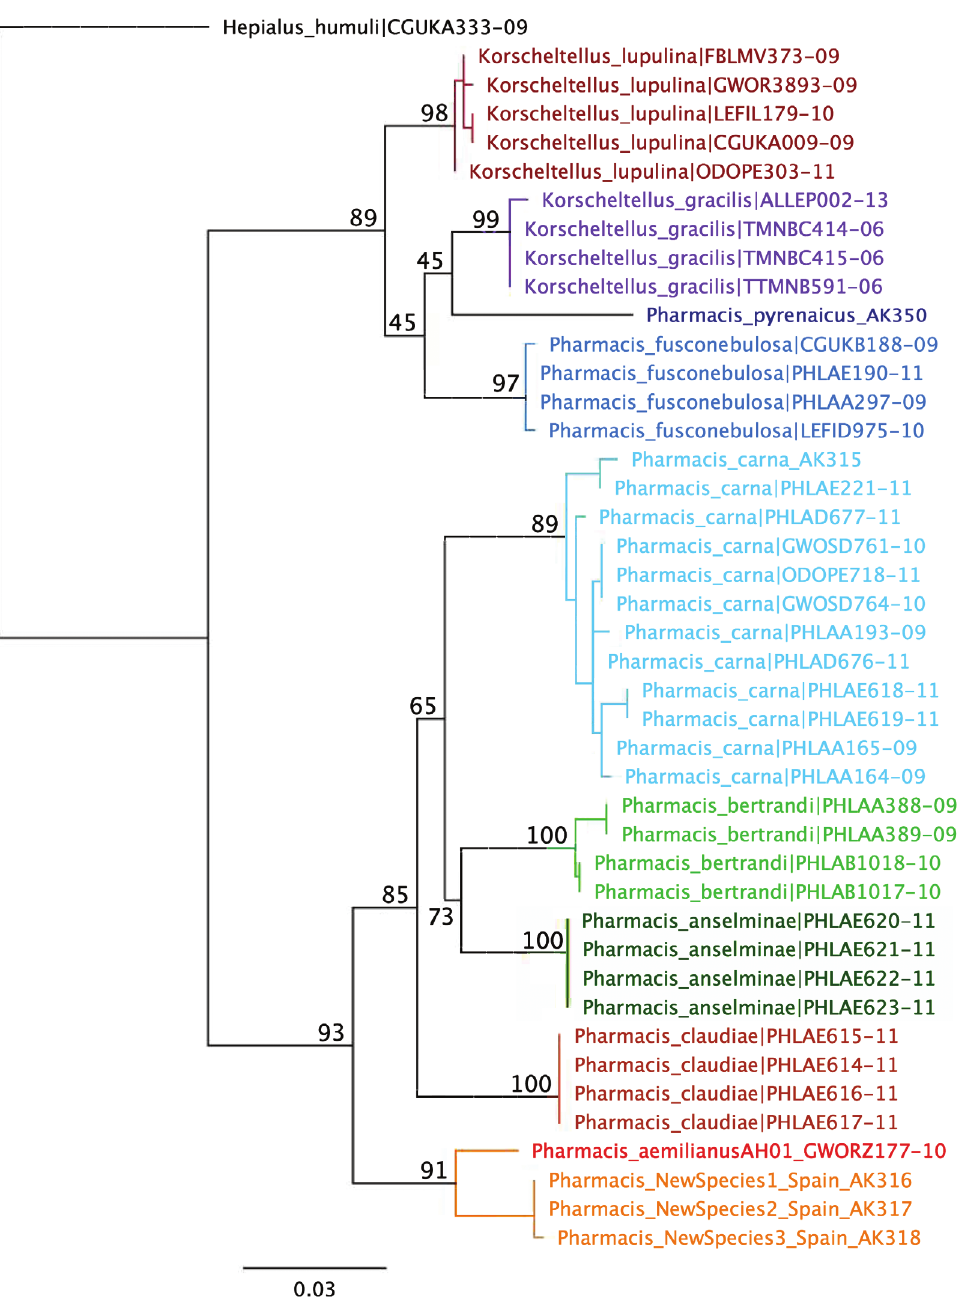
Figure 4. Maximum likelihood (ML) tree inferred from COI sequences for the genera Pharmacis and Korscheltellus , with the outgroup Hepialus humuli . Branch lengths are proportional to ML estimated branch lengths.Values above the branches are percentage of ML bootstrap